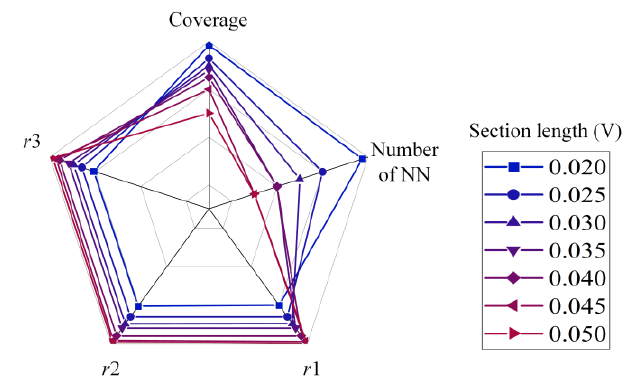
Figure 11. Variation of three selection indicators with section length.